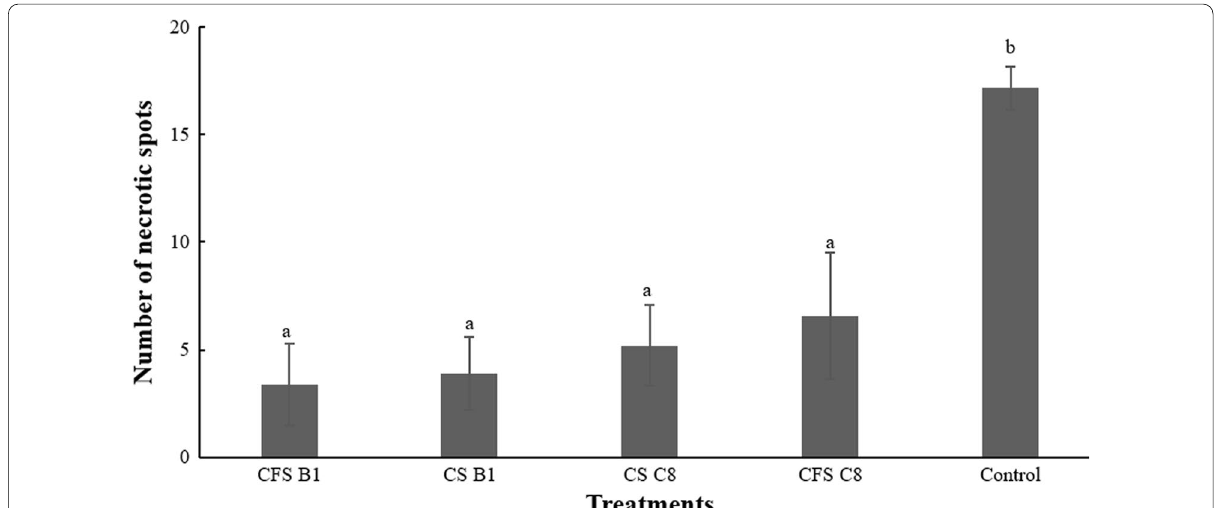
Fig. 9 Number of necrotic spots on the treated leaf after 4 weeks of experiments. Different letters on each histogram indicated any difference in the number of necrotic spots among treatments